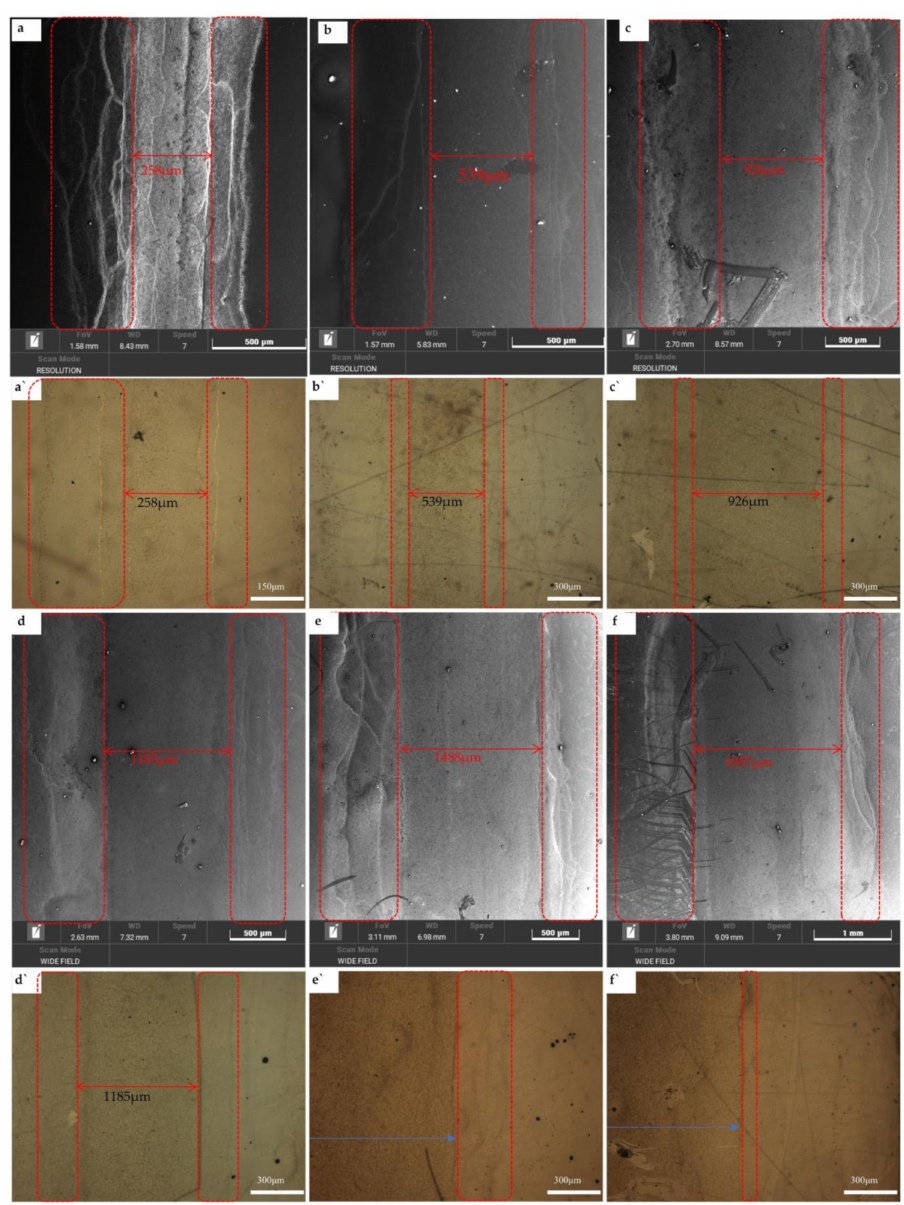
Figure 12a–f shows SEM images of those in Figure 11b from the printed patterns of a–f, and Figure 12a (cid:48) –f (cid:48) are the corresponding optical microscope photographs. The real widths of the patterns on the PET substrate with 200 µ m, 500 µ m, 800 µ m, 1100 µ m, 1400 µ m, and 1700 µ m are 258 µ m, 539 µ m, 926 µ m, 1185 µ m, 1488 µ m, and 1857 µ m; and the difference between the real value and the design value are 58 µ m, 39 µ m, 126 µ m, 85 µ m, 88 µ m, and 157 µ m, respectively. Comparing Figure 2 (pattern with 2 cm × 2 cm), the inkjet-printed AgNWs narrow linear patterns are prone to the phenomenon of AgNWs accumulation and overflow of both the edges due to the presence of coffee rings [9,32,33]. For the thin linear pattern, heat is readily transferred from the substrate to the thin pinned edge of the drop, leading to enhanced evaporation near the drop’s edge compared to that at the center [34,35]. It means that the effect of temperature on coffee ring formation is enhanced. Hence, the droplet displays a greater transfer of solute to its edge when subjected to heating.